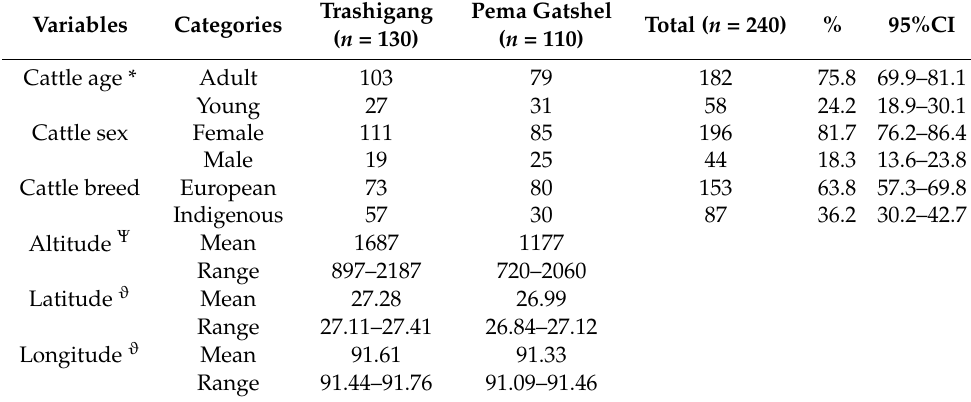
Table 5. Characteristics of the explanatory variables ( n = 240) used for the logistic regression analyses.